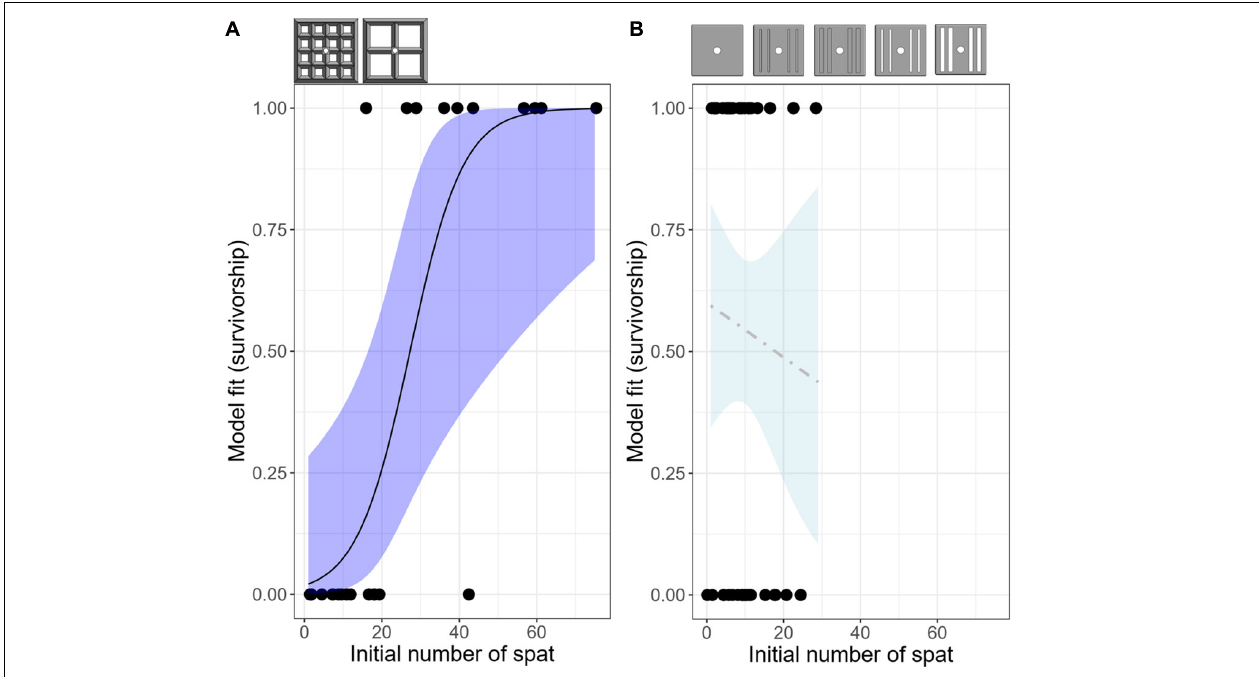
FIGURE 5 | Logistic models predicting the probability of having at least one surviving recruit on each deployed device as a function of the initial number of spat present on that device at the time of deployment, for all lattice-grid (A) and grooved-tile (B) devices. n = 24 for the lattice-grids and n = 44 for the grooved-tiles. Shaded areas indicate confidence intervals; dark blue indicates a statistically significant model whereas light blue indicates a non-significant model. Reference diagrams of device types included in each model are above their respective plots.